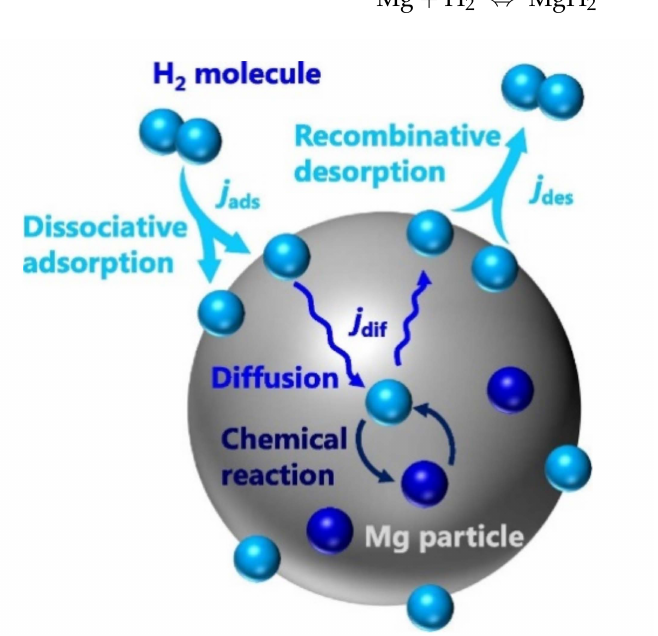
Figure 4. Conceptual schematic of our hydrogen-dynamic model. j ads , j des , and j dif denote the fluxes of hydrogen dissociative adsorption, recombinative desorption and diffusion, respectively [40]. (Reprinted with permission from